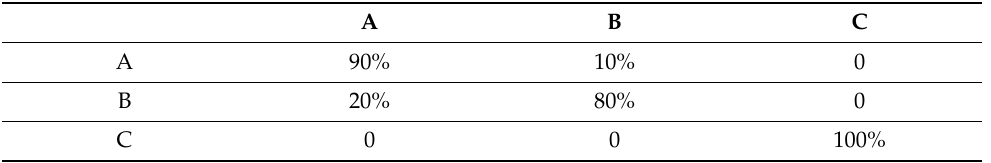
Table 9. Confusion matrix achieved for the Low Acidity variety accessions of set 2: A, Piralima IAC 2, B, Lima IAC 9 and C, Piralima IAC